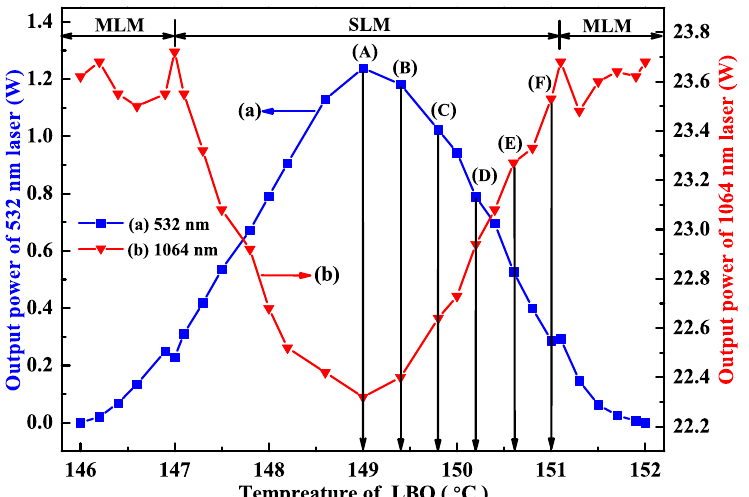
Figure 4. The output powers of the fundamental wave and second harmonic wave, respectively [23]. Reprinted with permission from [23] c (cid:13) Chinese Optics Letters.